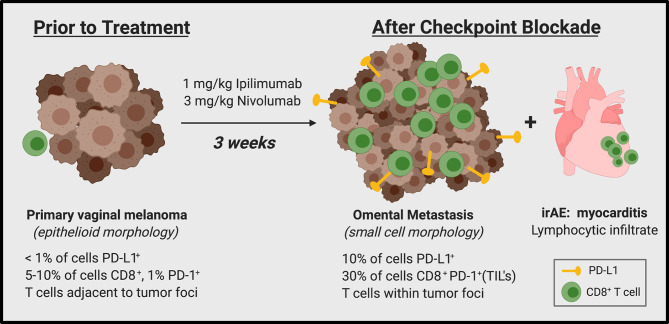
Summary of case.